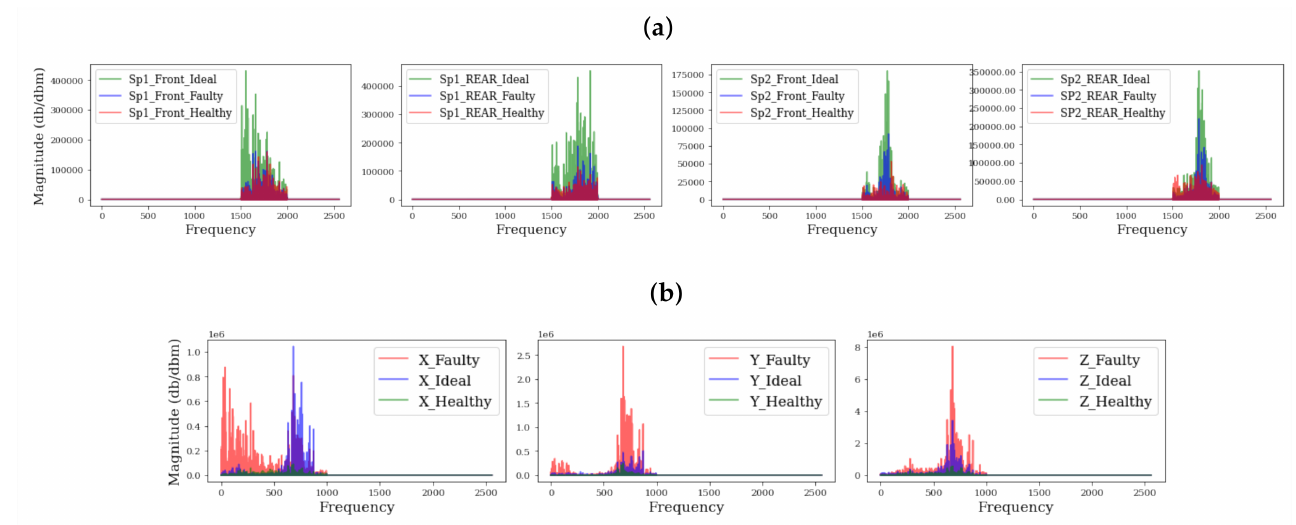
Figure 7. Spectral comparison of different grinder health states. ( a ) Spindle (critical segment),